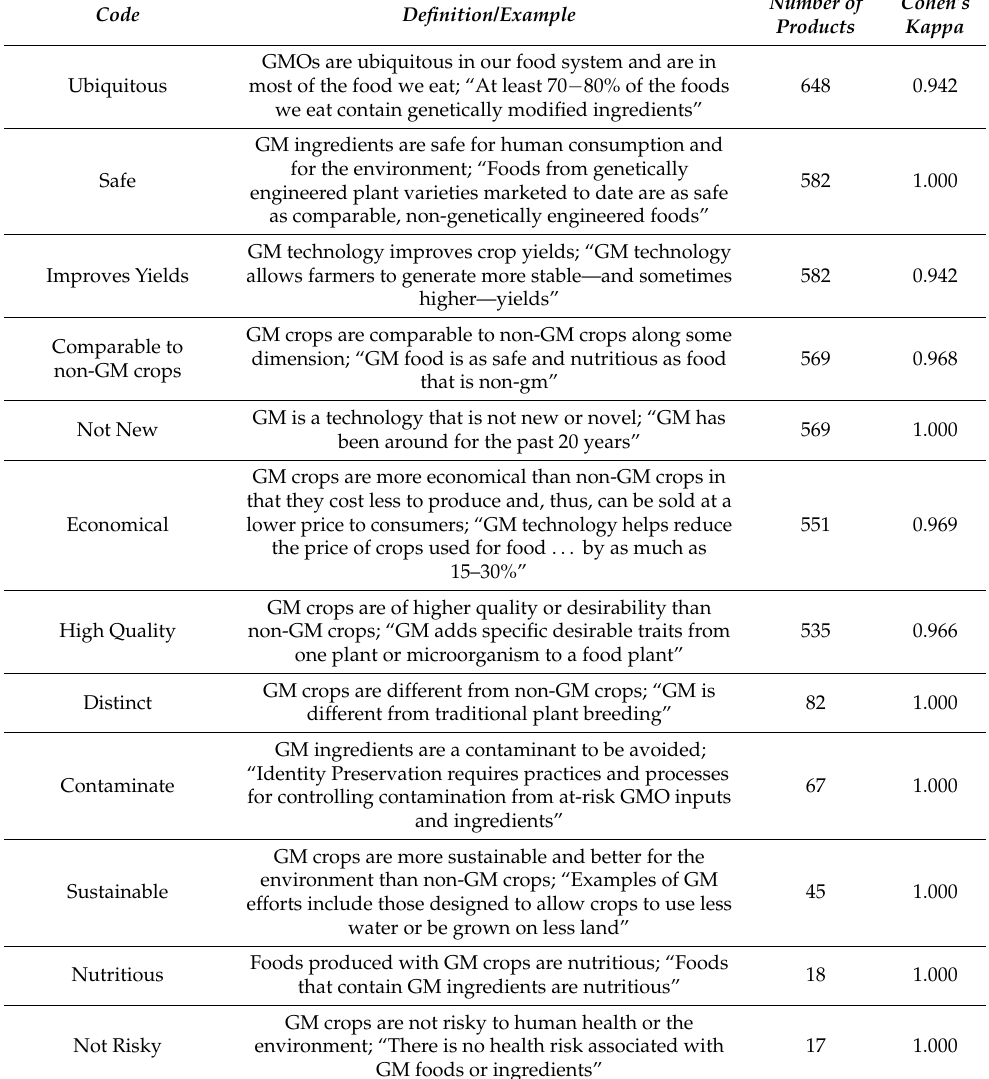
Table 2. Summary of GM